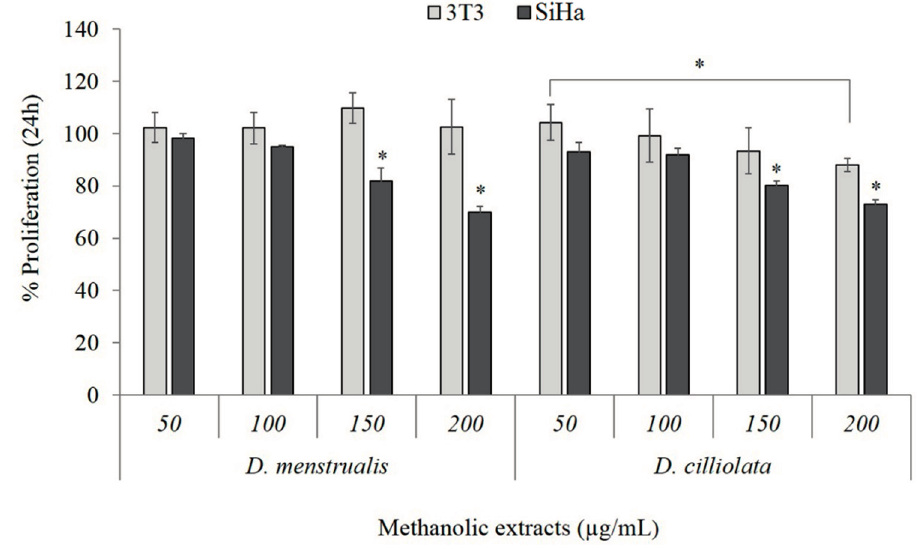
Figure 2. Effect of MEDM and MEDC on 3T3 and SiHa cells viability after 24 h of incubation. Data are expressed as mean ± standard deviation. * Indicates significant difference ( p < 0.01) among the different concentrations of